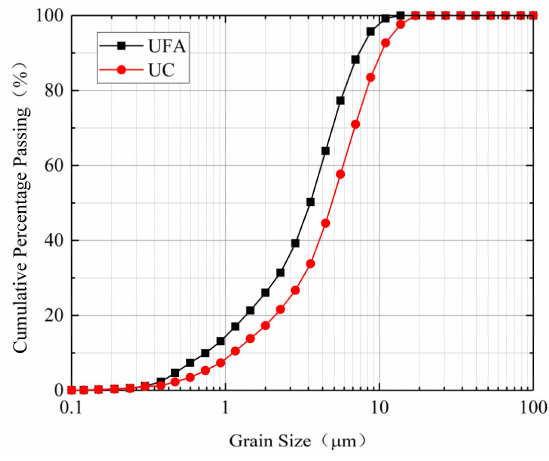
Figure 4. Particle size distributions of UC and UFA.